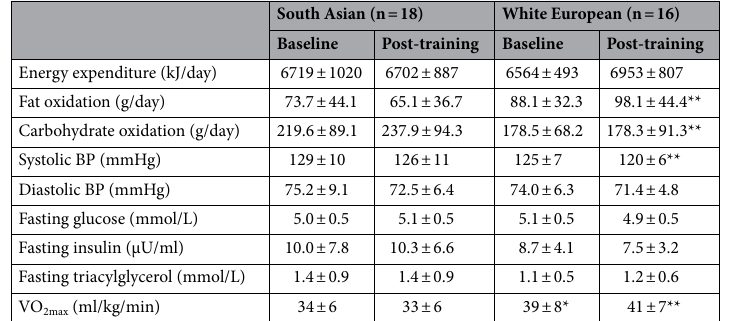
Table 2. Blood pressure, resting metabolic rate, blood and VO 2max data at baseline and after exercise training in South Asian and White European volunteers. Data are presented as mean (SD) * denotes a significant ( p < 0.05) difference between the groups at baseline (paired t-test) and ** denotes a significant ( p < 0.05) difference between the groups in response to training